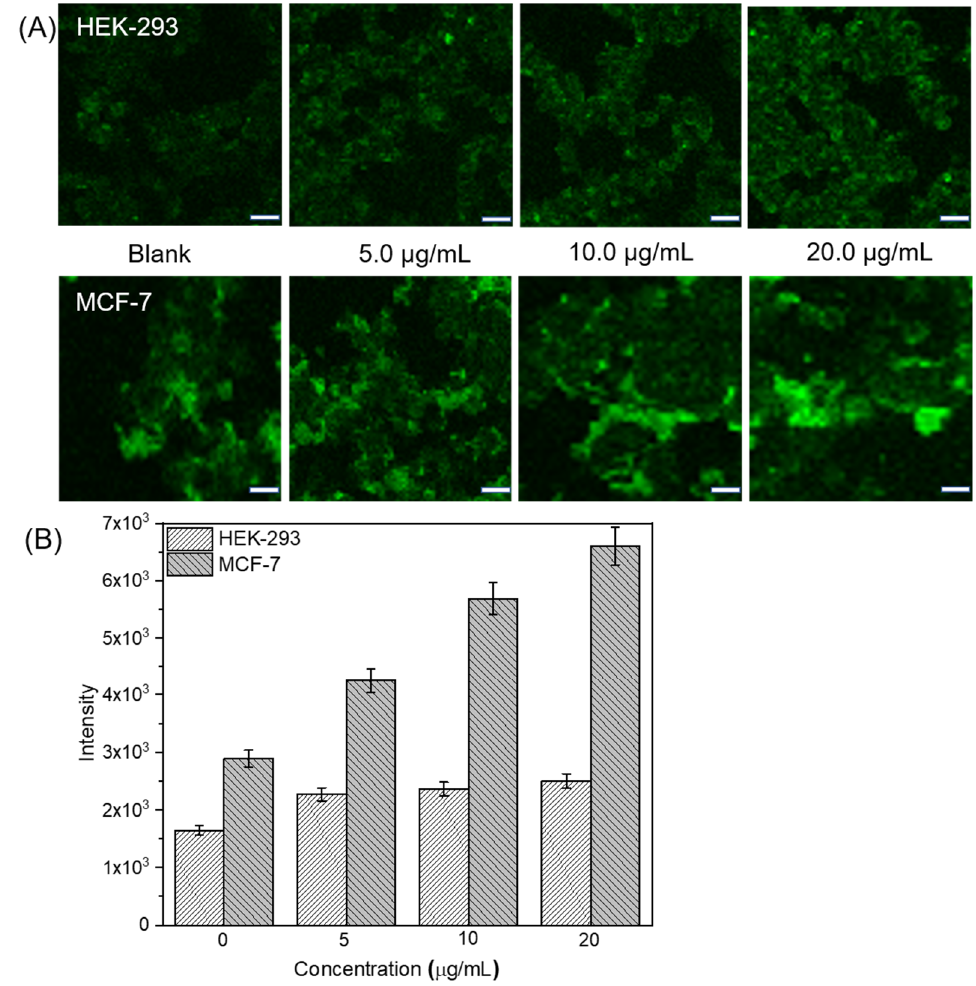
Figure 5. Evaluation of ROS-generating ability of DTTP micelles. CLSM images of HEK-293 normal and MCF-7 cancer cells treated with different DTTP micelle concentrations for 4 h ( A ). Scale bar: 20 µ m. Quantitative UN-SCAN-IT analysis of CLSM images obtained for HEK-293 and MCF-7 cells treated with various DTTP micelle concentrations for 4 h ( B ).